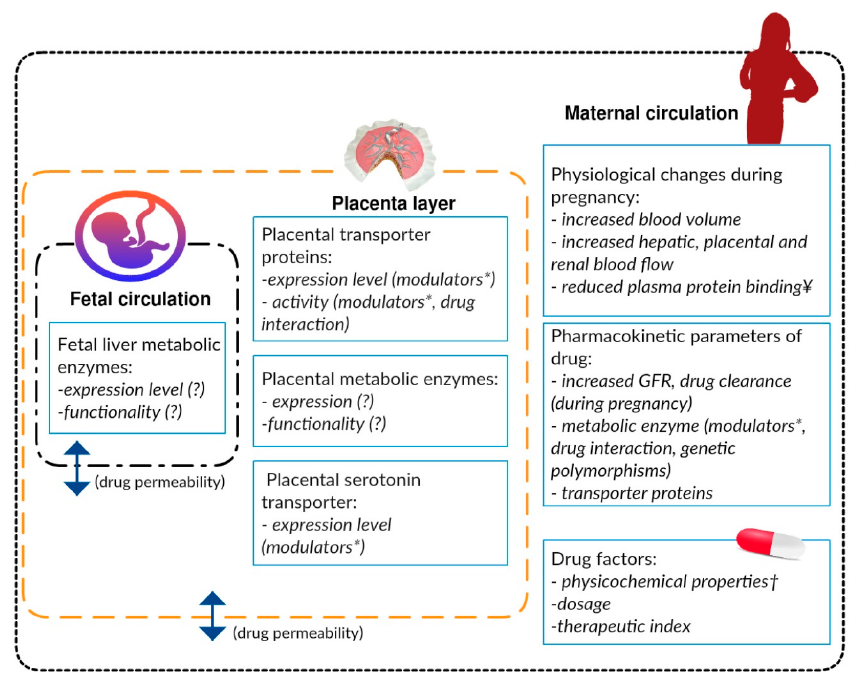
Figure 1. Factors influencing foetal drug exposure divided into factors in the maternal circulation, placenta layer and foetal circulation: *, substances that induce or inhibit the activity of enzymes/transporters, which may include pregnancy hormones and other drugs taken by the mother; ¥, important for serotonin reuptake inhibitors (SRIs) with high protein binding (e.g., fluoxetine, paroxetine, sertraline); † molecular size, polarity, charge, and lipophilicity of the drug; GFR, glomerular filtration rate; the double headed arrows indicate passive diffusion of drugs.